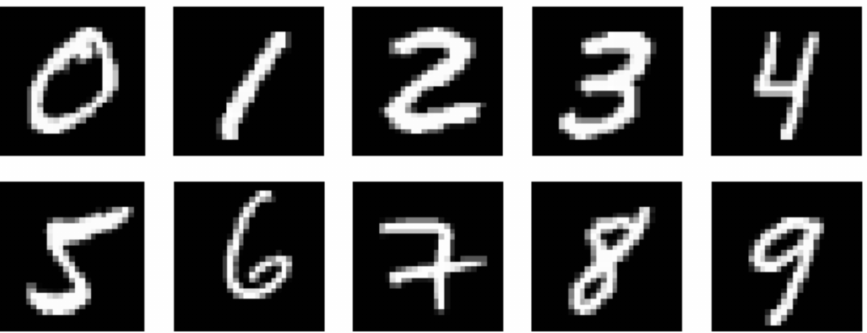
Figure 2. Examples of images from MNIST.